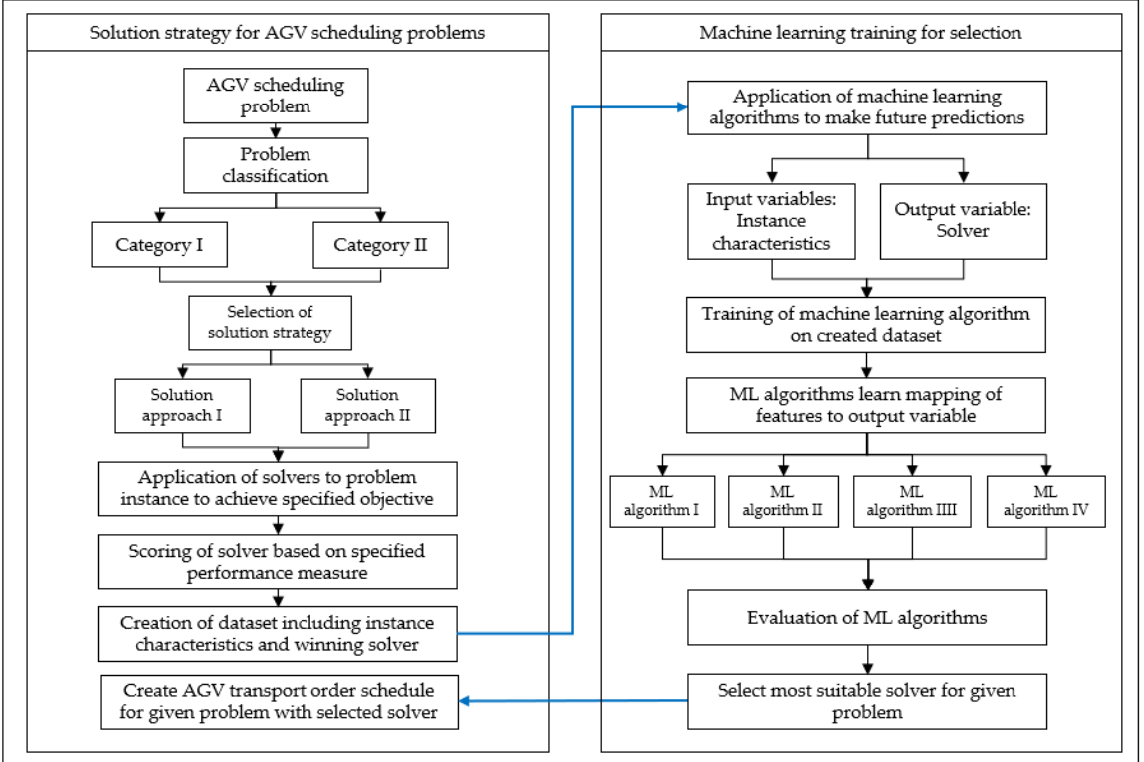
Figure 2. Theoretical concept of the algorithm selection approach.